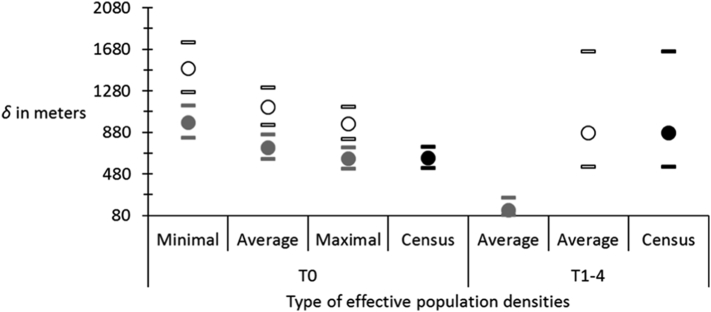
Dispersal (δ) of Glossina palpalis palpalis in Bonon and Sinfra (Ivory Coast) for different effective population densities (minimal, averaged and maximal) and different methods: using the threshold distance for genetic subdivision for defining the surface occupied by a subpopulation (grey), using the average sampling surface of the different sites (empty symbols) and using the census population density. The 95% confidence intervals computed from the isolation by distance slope after 5000 bootstraps over loci are represented as small dashes. Estimates are given for subsamples before control campaigns (T0) and after (T1–4) and were all made from Rousset's isolation by distance model between contemporaneous subsample pairs only. (For interpretation of the references to colour in this figure legend, the reader is referred to the web version of this article.)